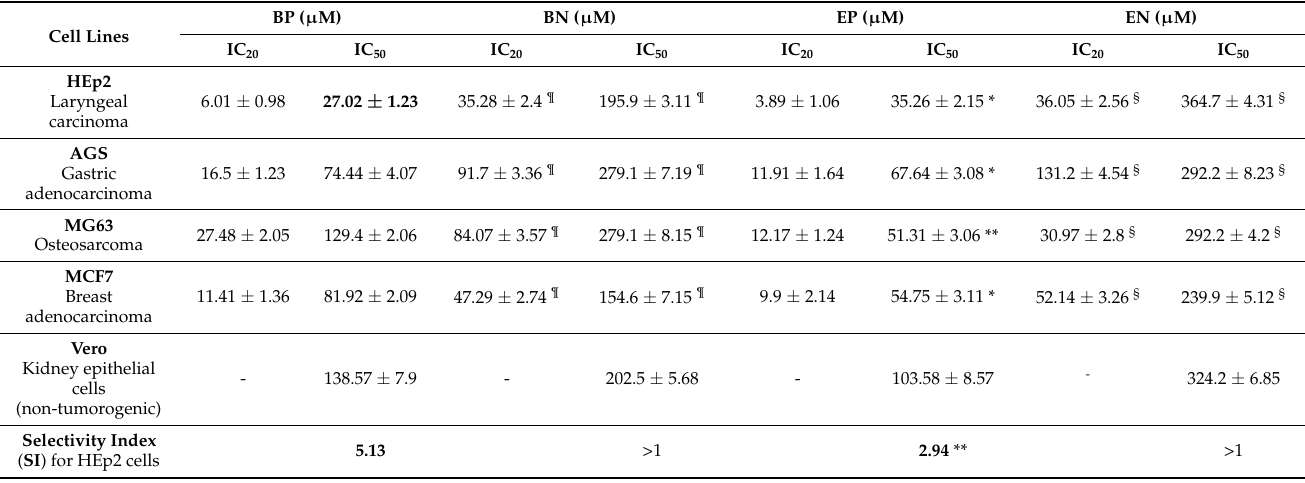
Table 1. Growth inhibitory concentration (IC 20 and IC 50 ) values of benzo[b]thiophene analogs against various cancer cell lines as per MTT